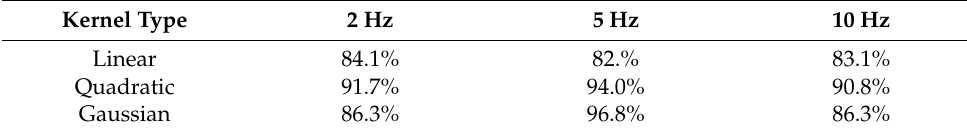
Table 3. Accuracy of each single-frequency hammering in the two-category classification.